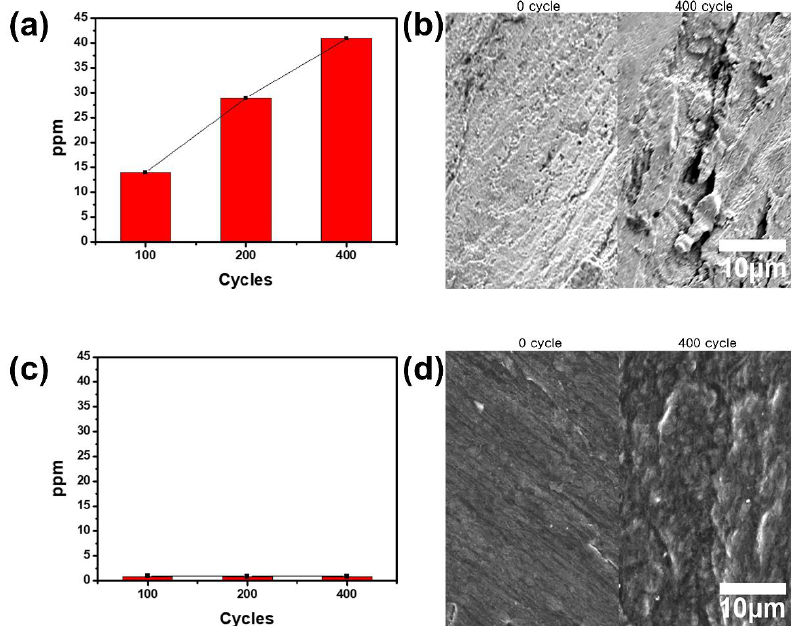
Figure 3. Microstructure and chemical composition of 304 stainless steel after electropolishing. ( a ) SEM image of pristine 304 stainless steel and stainless steel after ( b ) electropolishing at the Cu electrode and ( c ) M-GNP electrode. Auger depth profiling analysis of ( d ) pristine 304 stainless steel and stainless steel after ( e ) electropolishing at the Cu electrode and ( f ) M-GNP electrode.